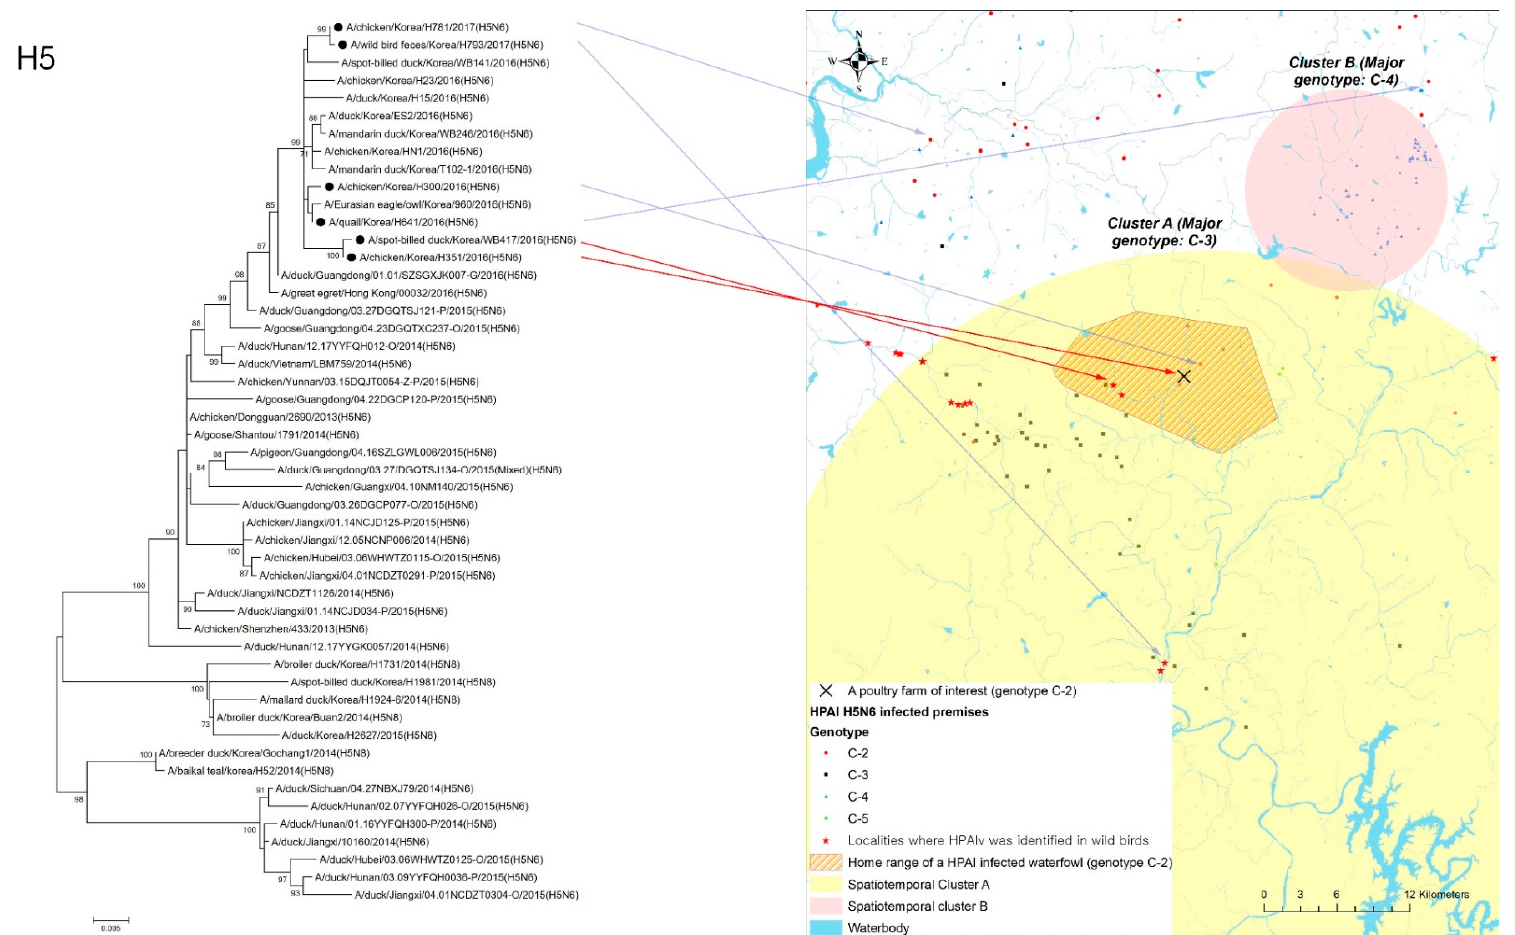
Figure 5. Phylogenetic tree for hemagglutinin (HA) gene of highly pathogenic avian influenza (HPAI) virus isolates from one H5N6-positive spot-billed duck and one chicken farm located inside its home range.Black circle in the tree denotes the isolates from one HPAI-infected waterfowl, one infected premise indicated by a red arrow, a neighboring infected premise, two other infected premises, and another infected wild bird, respectively, located in C-2 a genotype-prevalent area, indicated by a blue arrow.